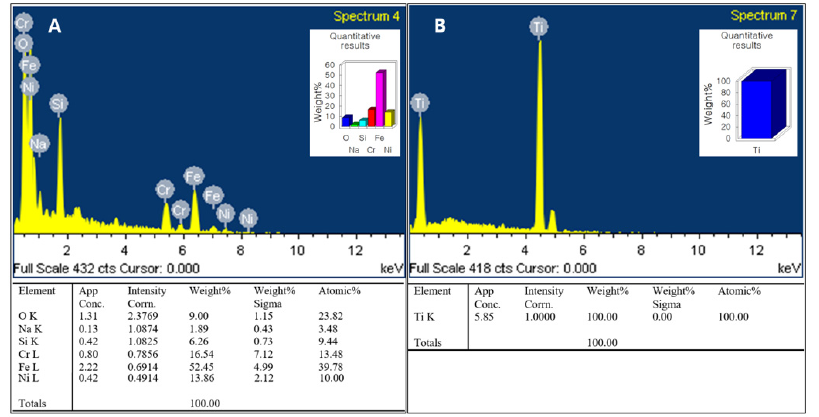
Figure 1. EDS of ( A ) the SUS-machined group and ( B ) the SUS-DMF group. Compared to ( A ) the machined specimen, ( B ) the SUS–DMF group showed an absolutely different pattern, showing high peaks of